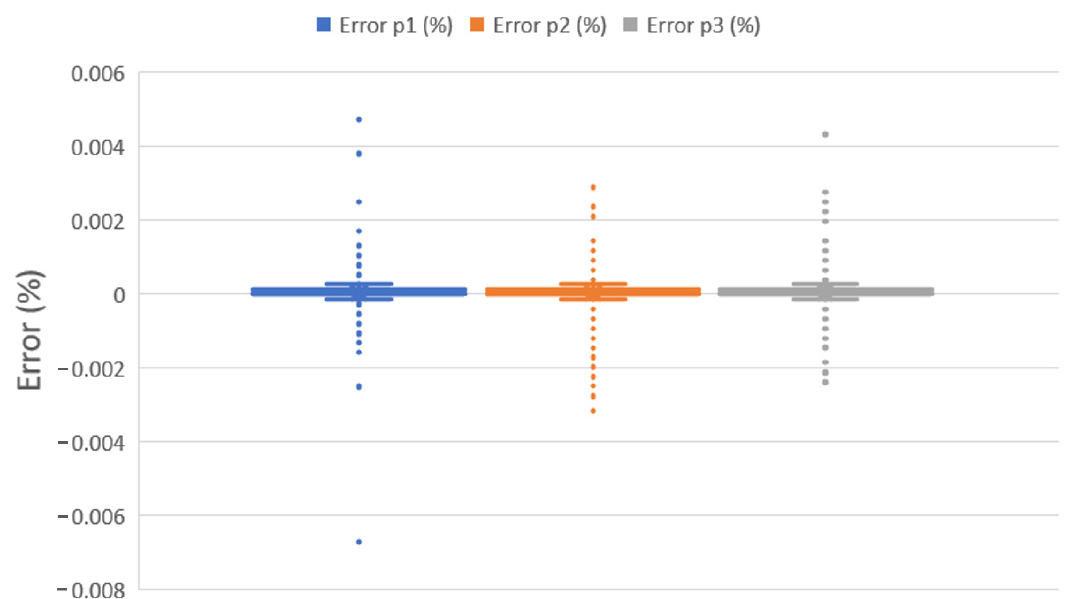
Figure 3. Errors calculated at Circuit 5 feeder’s head, yearly simulation, two zones; p1, p2, and p3 are the phases.